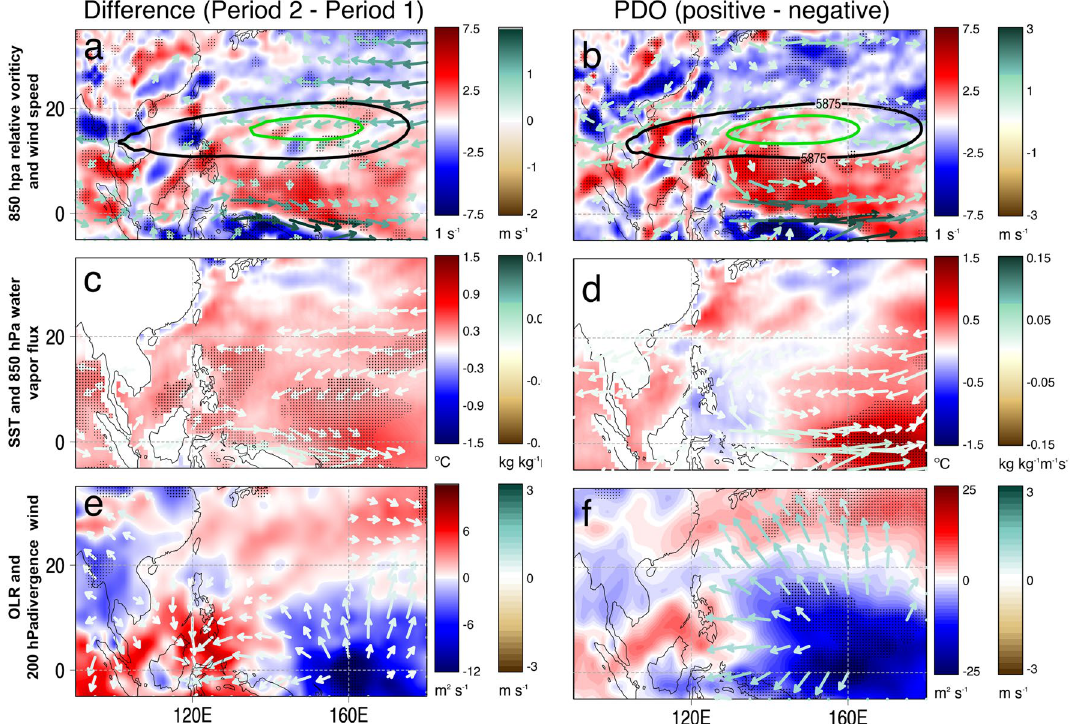
Figure 3. Composite analysis of indicated variables. Left panel, Composite difference between Period 2 and Period 1 showing 850 hPa relative vorticity (shaded) and wind speed (vector) ( a ), sea surface temperature (shaded) and 850 hPa water vapor flux ( c ) and outgoing longwave radiation (shaded) and 200 hPa divergence wind (vector) ( e ). Right panel, Similar to left panel but showing the difference between positive and negative PDO years ( b – f ). The magnitude of difference in the shaded and vector variables is shown in their respective scale bars. The black dots indicate significant difference at p < 0.05 level, two-tailed. In ( a – b ), the 850 hPa relative vorticity is multiplied with 1,000,000 for scaling while the black (green) contour shows the location of the WNP subtropical high during Period 2 (Period 1) and positive (negative) PDO phase, respectively. The maps are plotted using GrADS v2.2.1 (http:// openg rads.